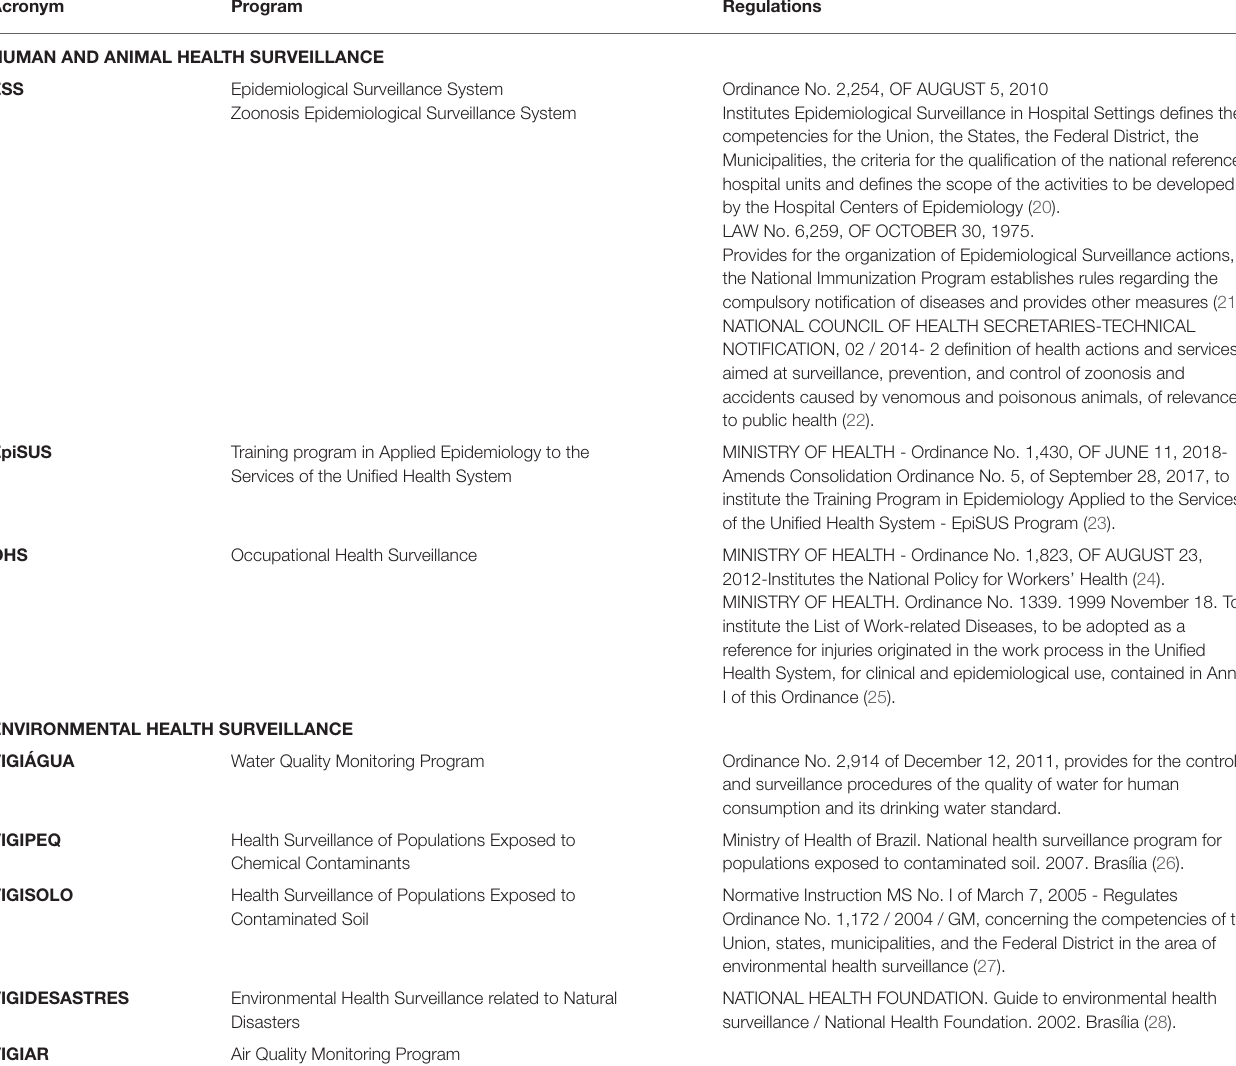
TABLE 1 | Organizational components of Health Surveillance System (HSS) programs and policies regarding the human, animal, and environmental